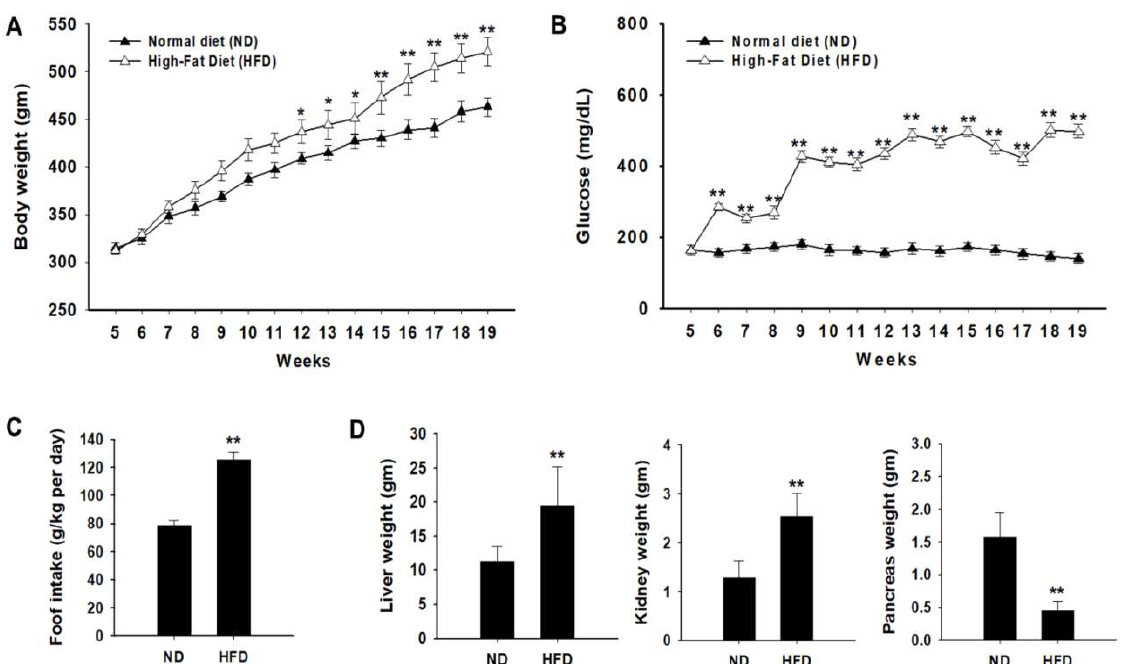
Figure 1. Effects of a high-fat diet (HFD) on body weight and organ weight. Zucker diabetic fatty (ZDF) rats were divided into two groups: (1) the normal diet (ND) and (2) HFD groups. ( A ) Weekly body weight changes were measured in each group. ( B ) Effect of HFD on fasting blood glucose concentration (mg/dL) was monitored. ( C ) Food intake was measured during the experimental period. ( D ) The liver, kidney, and pancreas weights were measured in each group. Data of each group are expressed as the mean ± standard deviation (SD). * p < 0.05; ** p < 0.01. ND, normal diet; HFD, high-fat diet.